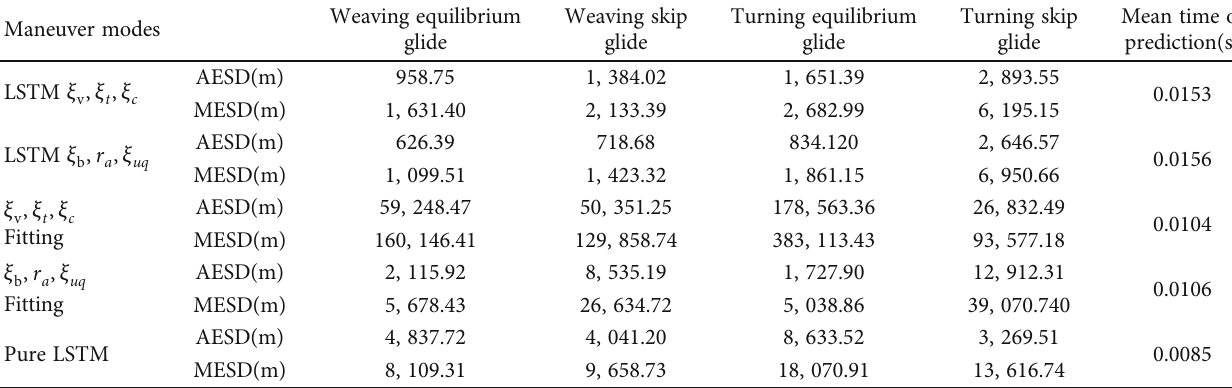
Table 4: Comparison of prediction results in 150 s for di ff erent methods. Weaving equilibrium Weaving Maneuver modes